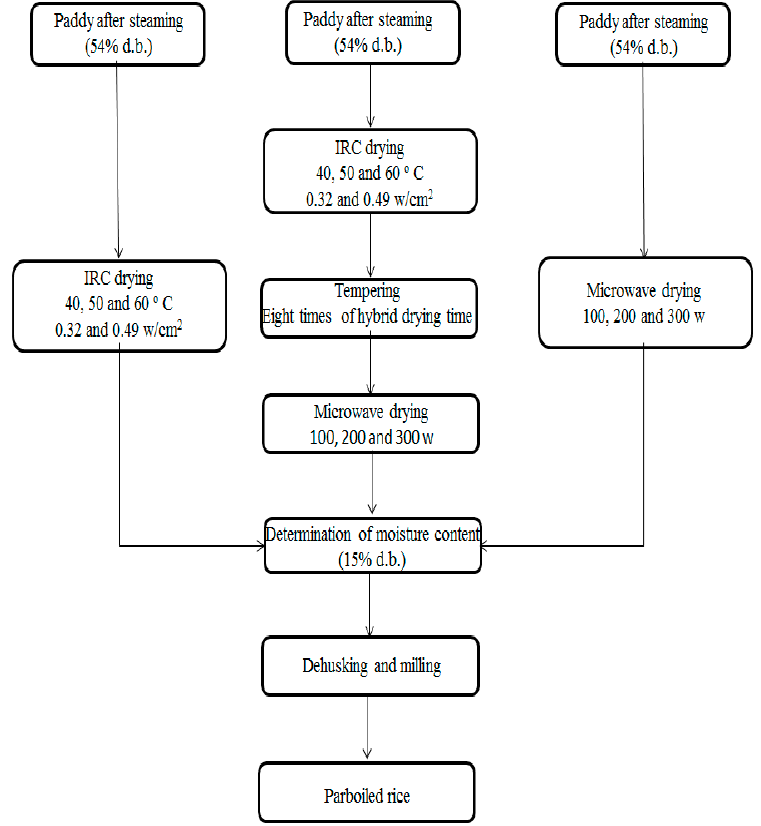
Figure 1. Experimental design for parboiled paddy drying (d.b.: dry basis) .